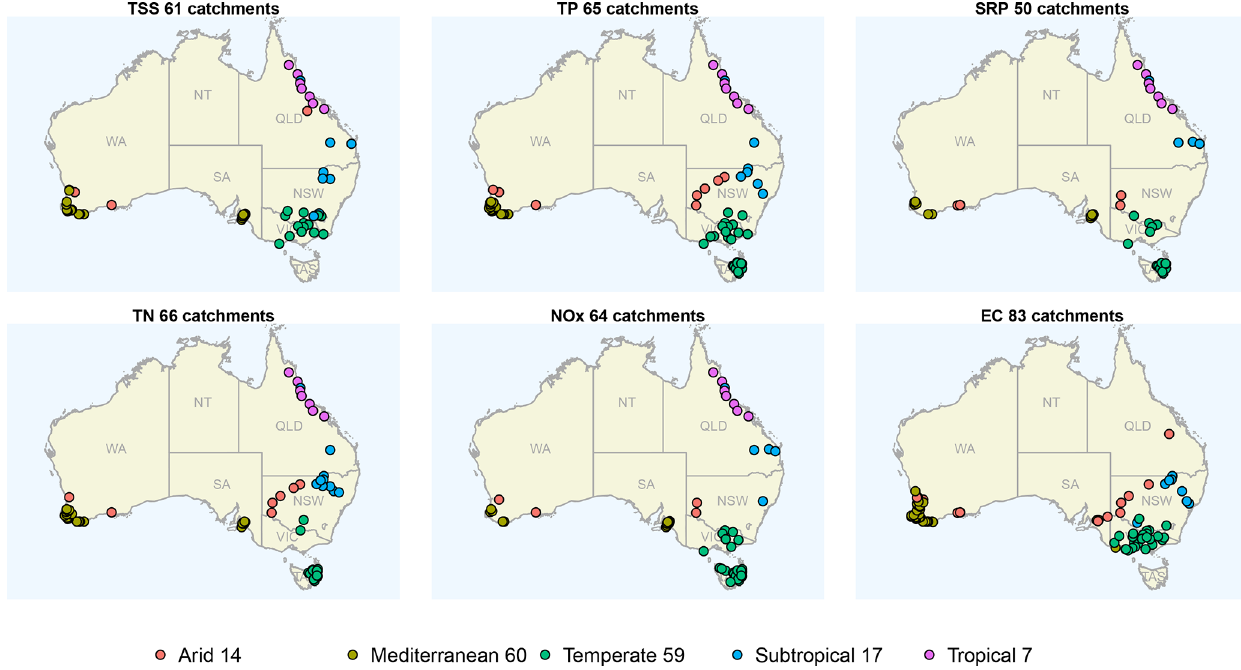
Figure 1. Catchments included in the study for each water quality variable (total number of catchments shown in panel titles). The colours denote five key climate zones in Australia. States and territories of Australia on the map are New South Wales – NSW, Queensland – QLD, South Australia – SA, Tasmania – TAS, Victoria – VIC, Western Australia -WA, and Northern Territory – NT. The number of catchments across all six water quality variables for each climate zone is specified in the